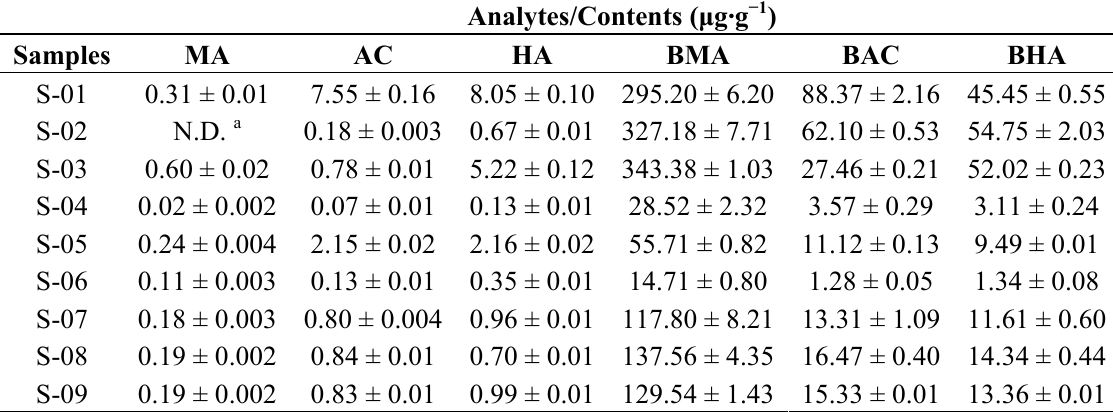
Table 5. The contents ( μ g·g − 1 ) of six targets in nine commercial samples (n =